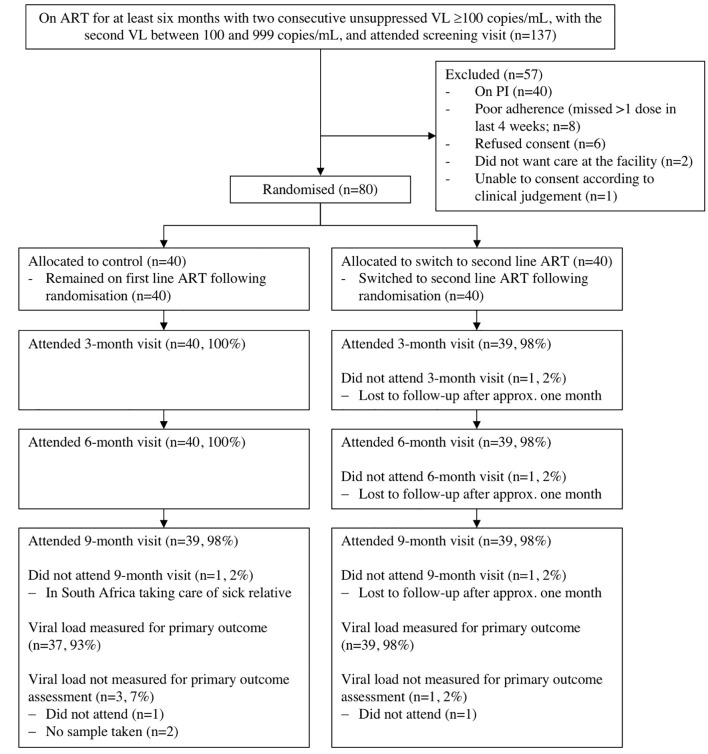
Participant flow diagram of SESOTHO trial.ART, antiretroviral therapy; LTFU, lost to follow-up; PI, protease inhibitor; SESOTHO, Switch Either near Suppression Or THOusand; VL, viral load